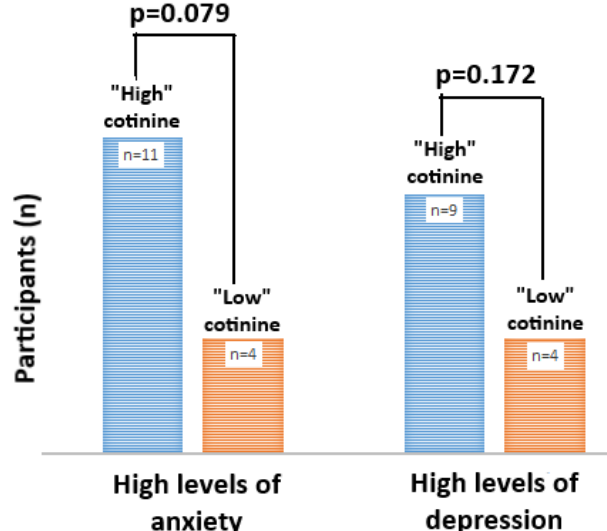
Figure 3. Relationship between caregiver cotinine classification criteria and mental health. Correlation (Pearson χ 2 ) of moderate-severe anxiety and depression among caregivers classified by “low”, versus “high” cotinine status.